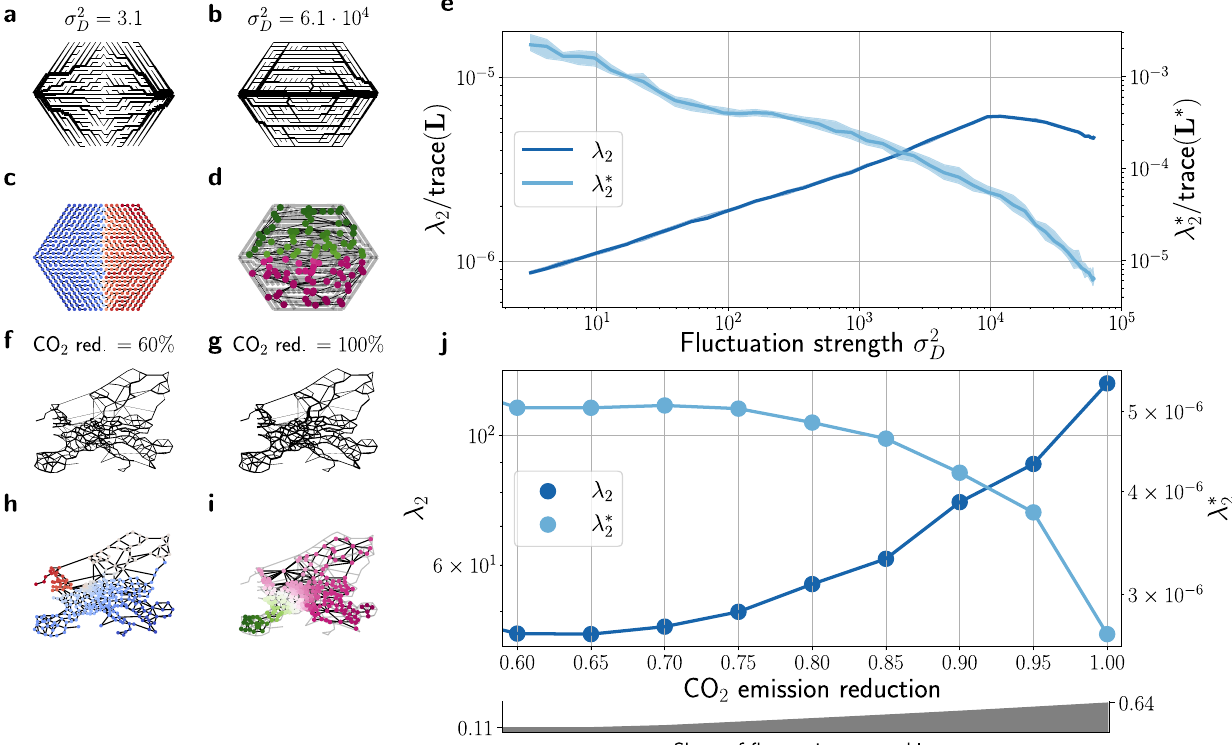
Fig. 5 | Primal and dual communities emerge naturally in optimal supply net- works. a , b We considera triangularlatticewith two fl uctuating sources located at theleftmostandtherightmostnodeandGaussiansinksattachedtoallothernodes. The strength of the two sources fl uctuates following a Dirichlet distribution with variance σ 2 D (see “ Methods ” ). For each value of σ 2 D , we fi nd the network structure andtheedge weights that minimize thetotaldissipatedenergy D assuming limited resources. c , d The optimal network structure shows a transition from primal to dualcommunitiesmeasuredbytheFiedlervectors(colorcode)oftheprimalgraph ( c ) or dualgraph ( d ). e The scaling ofthe corresponding primal( λ 2 , dark blue) and dual ( λ * 2 , light blue) Fiedler value con fi rms the transition. The shaded regions indicatethe25 – 75%quantilesfordifferentruns. f , g Atransitionfromprimaltodual